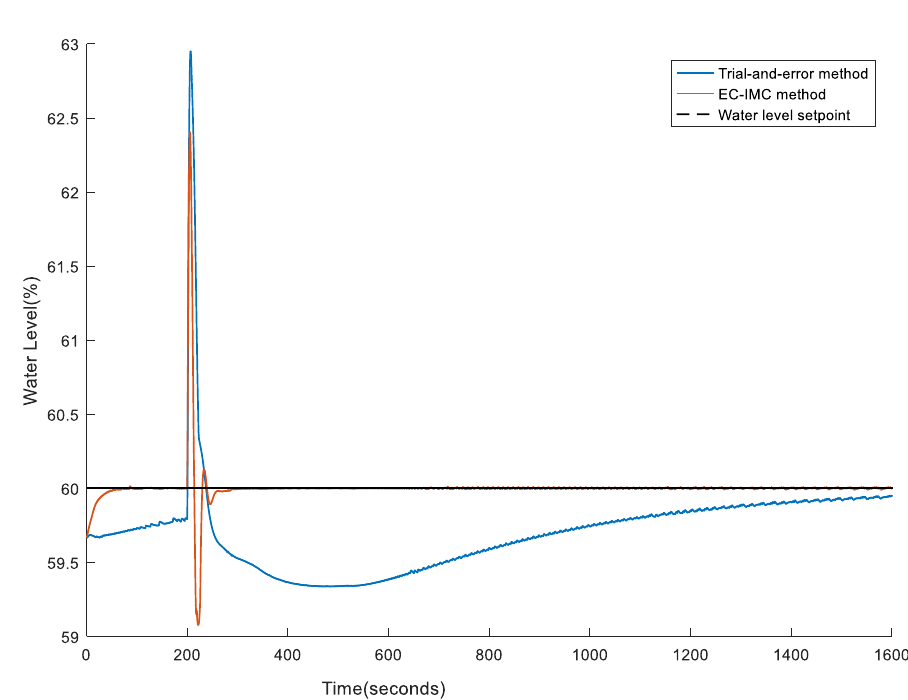
Figure 15. Water level response of power level step change from 30% to 40%.